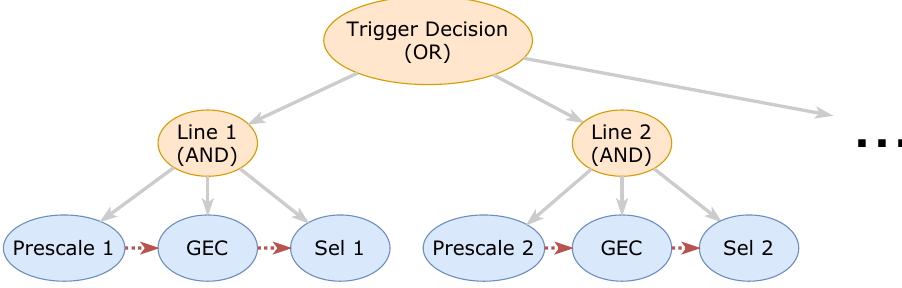
Figure 1. The control flow of a typical trigger application, with basic (blue) and composite (yellow) control flow nodes. Trigger lines can be prefixed by a ‘prescale’ to control their overall rate. A global event cut (GEC) can be used to remove the busiest events from the processing chain. Each line has a selection specific to the physics signature it tries to select, e.g. a specific particle decay like D 0 → π + π −